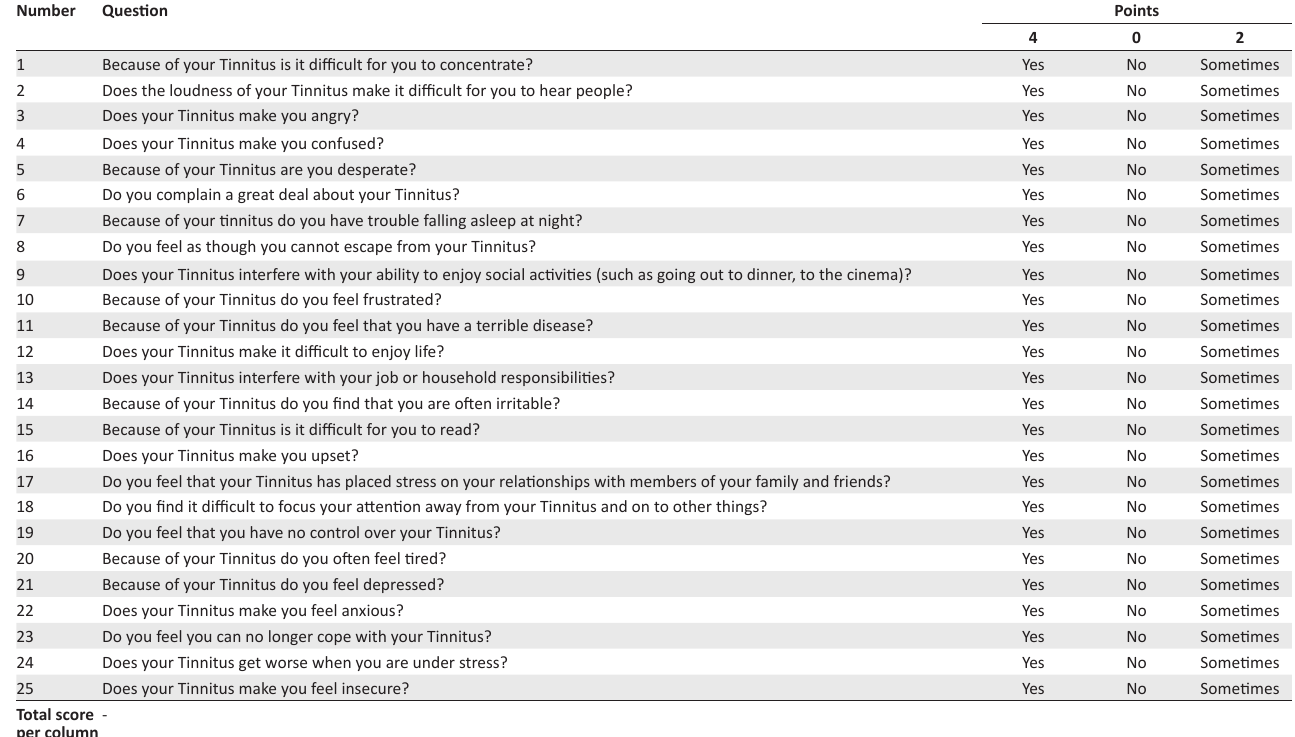
TABLE 1–A2: Tinnitus Handicap